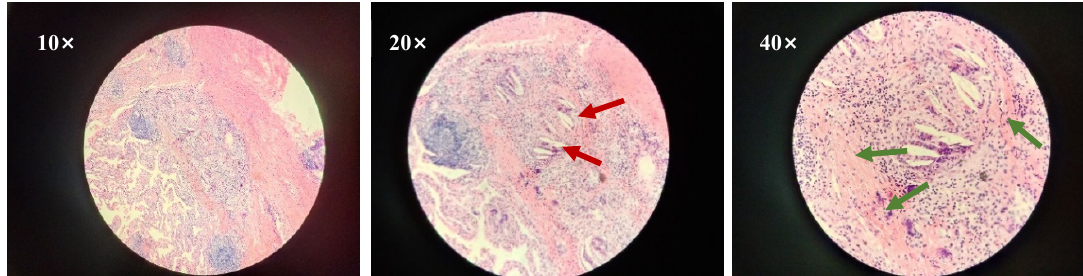
Figure 3. Hematoxylin–eosin staining of pathological results of postoperative specimens.